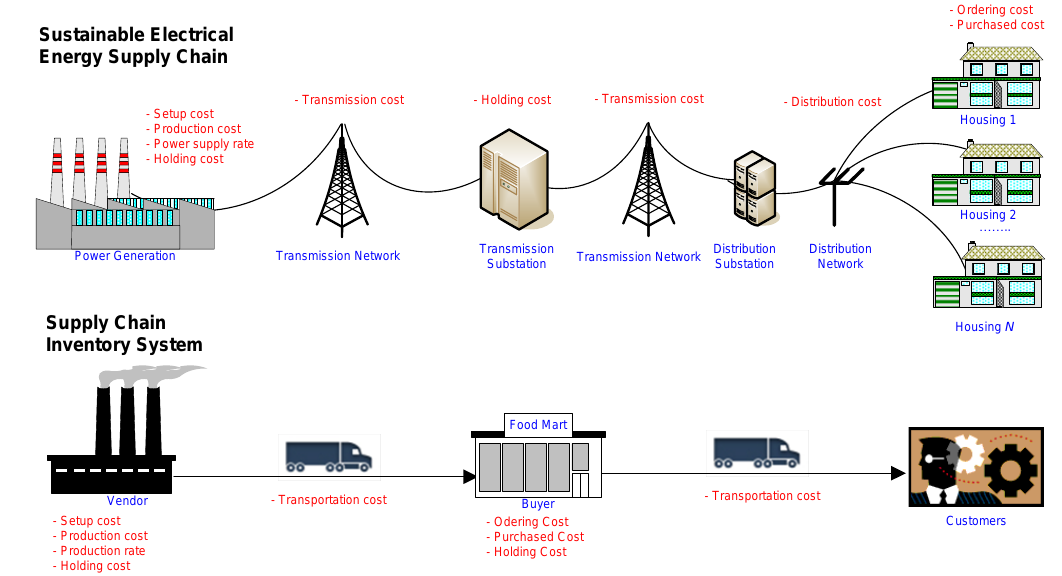
Figure 1. The analogies between Sustainable Electrical Supply Chain System (SESCS) and Supply Chain Inventory System (SCIS).